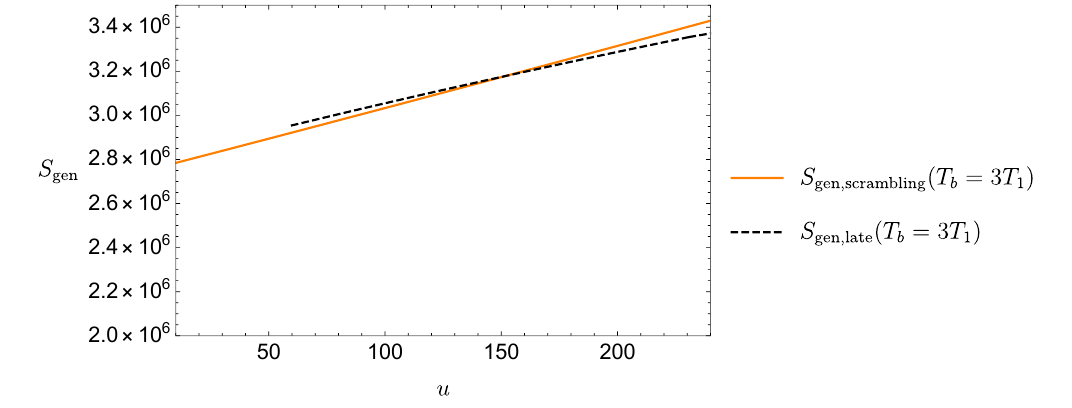
Figure 10 . The Page transition with “critical” bath temperature at T b = 3 T 1